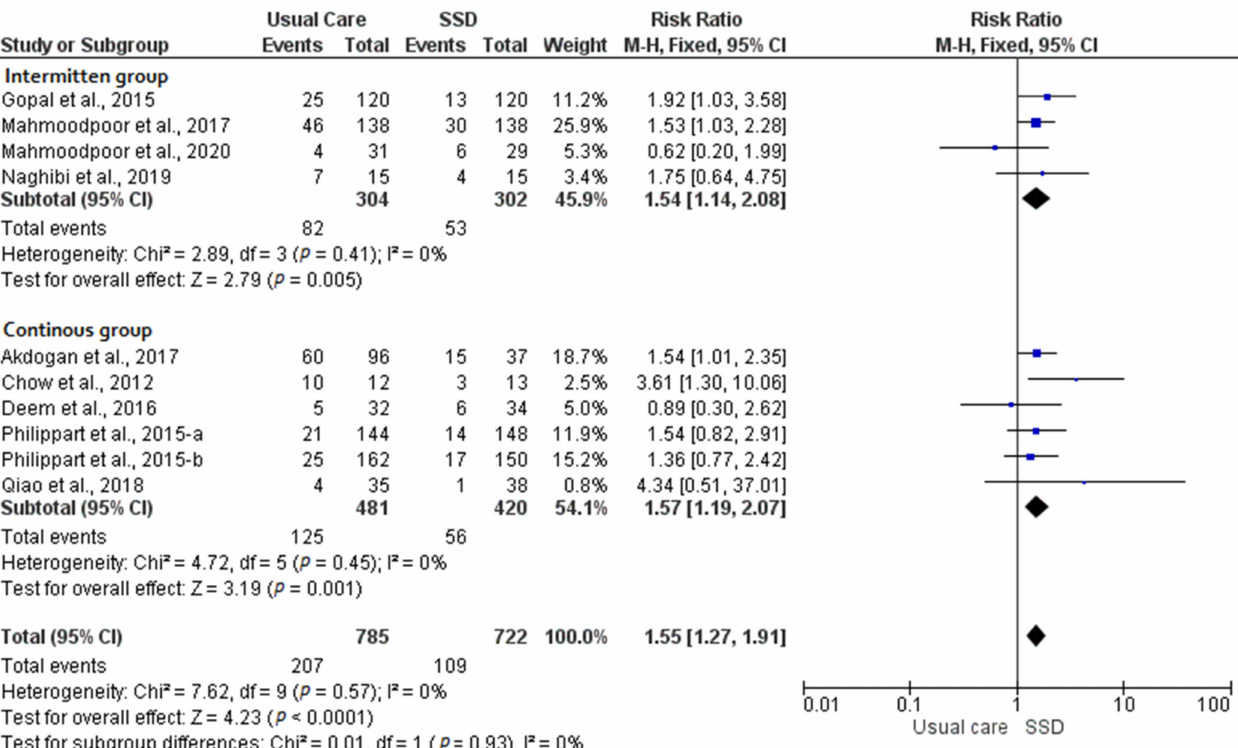
Figure 2. Risk of VAP in the usual care group vs. the SSD group.